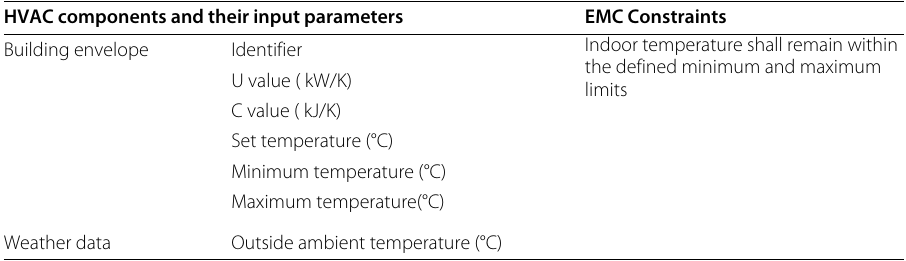
Table 4 Description of HVAC system and constraint HVAC components and their input parameters